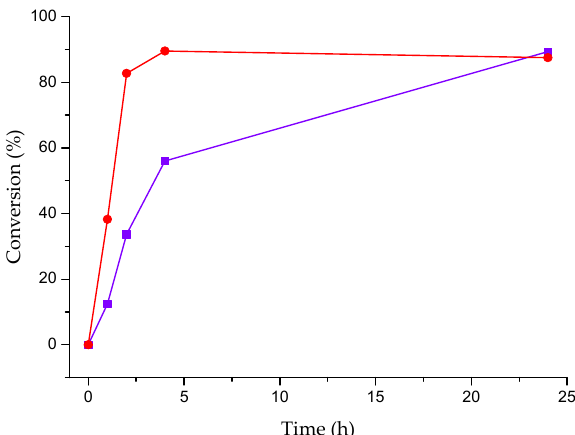
Figure 5. The dependence of the arabinoside 10b synthesis rate on the moment of arsenate addition. Red line: arsenate was added to the reaction at the start of synthesis. Violet line: arsenate was added to the reaction 24 h after the start of synthesis.